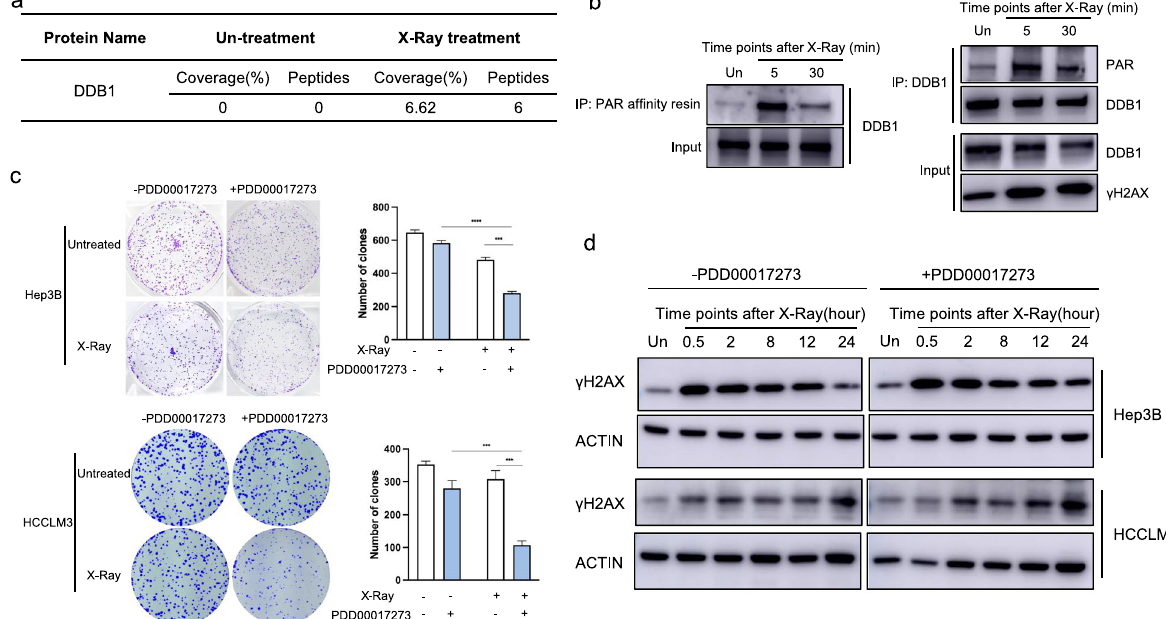
Fig. 1 DDB1 is PARylated in response to DNA damage and the inhibition of PARG impairs DSBs repair in HCC. a Coverage and peptides number of PARylated DDB1 detected by LC–MS. b The Hep3B cells were lysed and immunoprecipitated with Af1521 macrodomain (PAR/MAR) affinity resins or an anti-DDB1 antibody followed by western blotting with an anti-DDB1 antibody or an anti-PAR antibody at the indicated time points after X-Ray treatment (4 Gy). c Colony-formation assays were applied to assess the survival of Hep3B and HCCLM3 cells treated with X-Ray (1 Gy), with PARG inhibitor (1 μM). d Western blotting assays for the effect of PARG inhibition (2 μM PDD00017273) on the γH2AX expression level in Hep3B and HCCLM3 cells at the indicated time points after X-Ray treatment (4